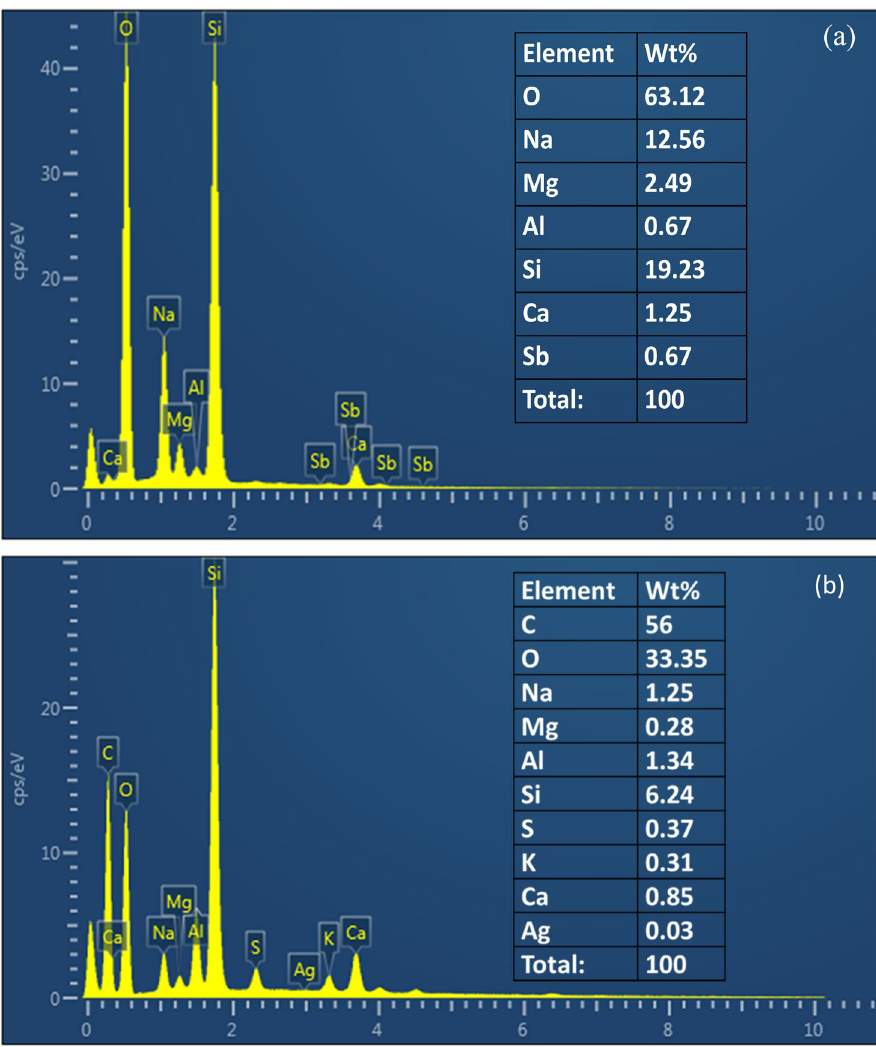
Figure 7. SEM micrograph of Ag–GO